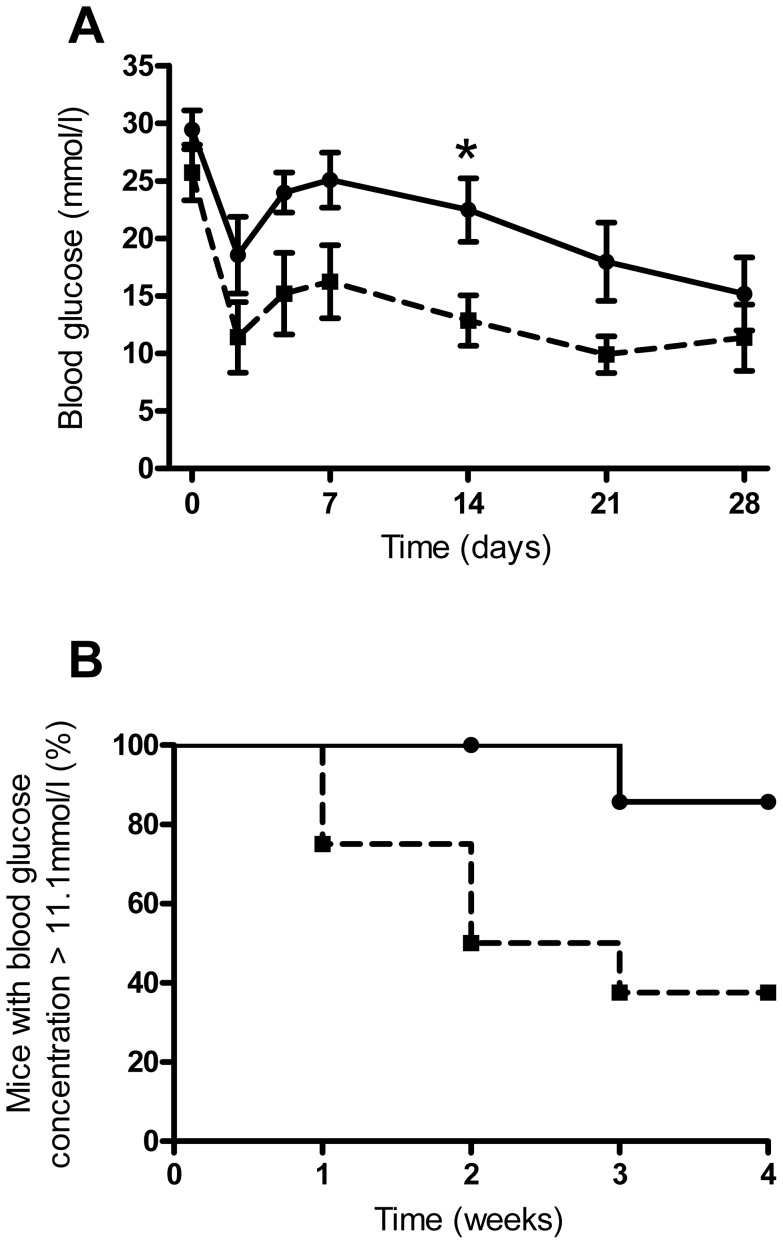
Efficacy of matrigel-implanted islets in vivo.A. Blood glucose concentrations of mice transplanted with pelleted islets alone (continuous line) or islets dispersed in matrigel (dashed line), beneath the kidney capsule, *p<0.05, Two-Way RM ANOVA with Bonferroni post hoc test, n = 7-8. B. Percentage of mice remaining diabetic (blood glucose concentration >11.1 mmol/l) after transplantation as in A, p = 0.02 Kaplan–Meier, n = 7-8.